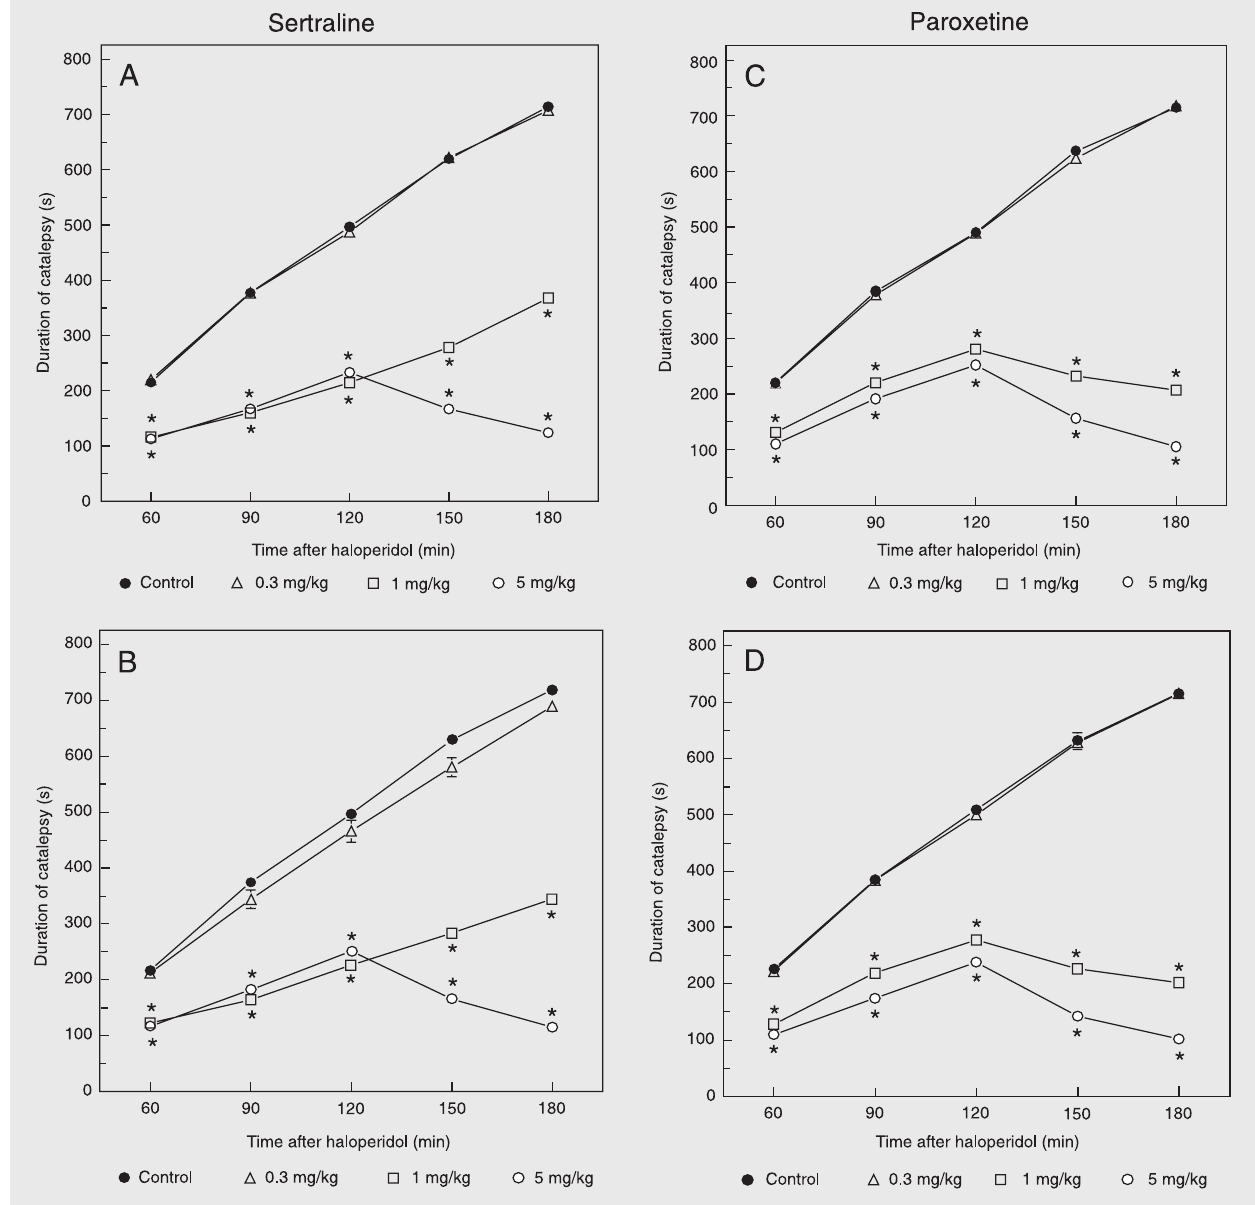
Figure 1. Effects of sertraline (A, B) and paroxetine (C, D) on haloperidol-induced catalepsy in male (A, C) and female (B, D) mice. The mice received 0, 0.3, 1.0, and 5 mg/kg, ip , of sertraline or paroxetine. Data are reported as means ± SEM for 12 mice per group. *P < 0.05 compared to vehicle (Dunnett